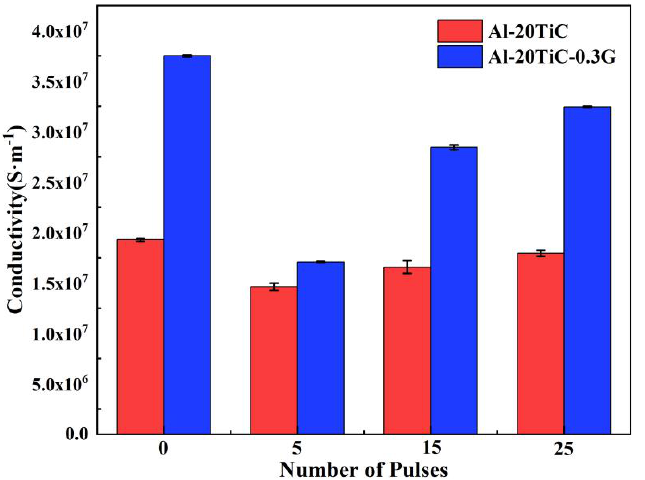
Figure 8. Changes in electrical conductivity of Al matrix composites before and after HCPEB.